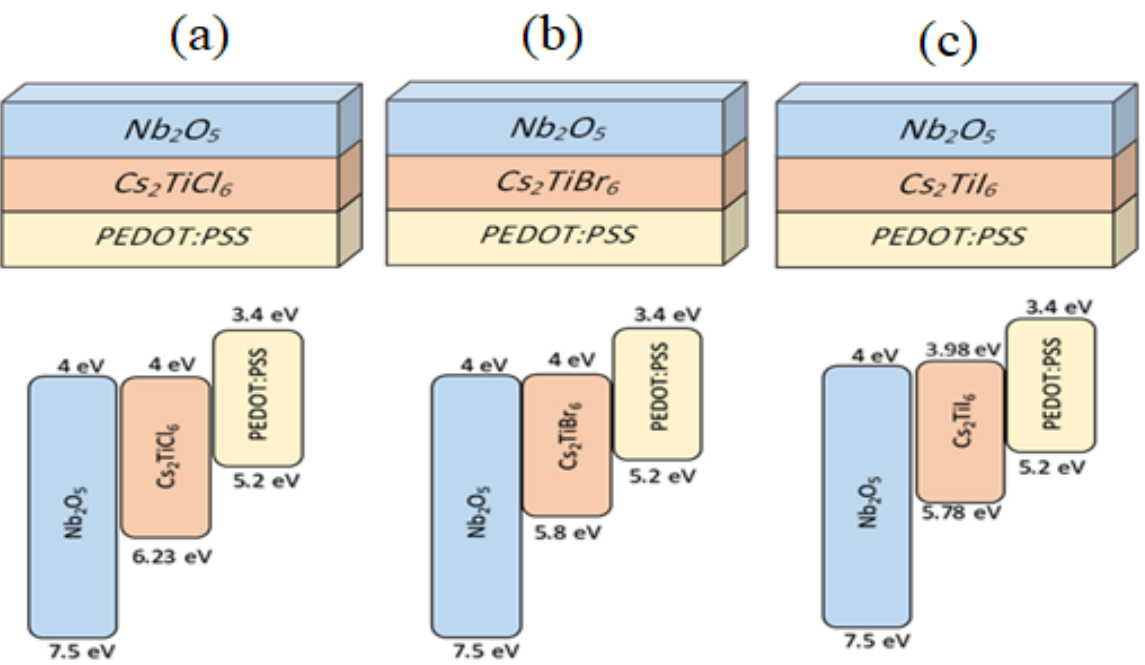
Figure 1. The devices’ structures and the energy band diagram for the proposed perovskite solar cell devices as: ( a ) Nb 2 O 5 /Cs 2 TiCl 6 /PEDOT:PSS , ( b ) Nb 2 O 5 /Cs 2 TiBr 6 /PEDOT:PSS , and ( c ) Nb 2 O 5 /Cs 2 TiI 6 /PEDOT:PSS .